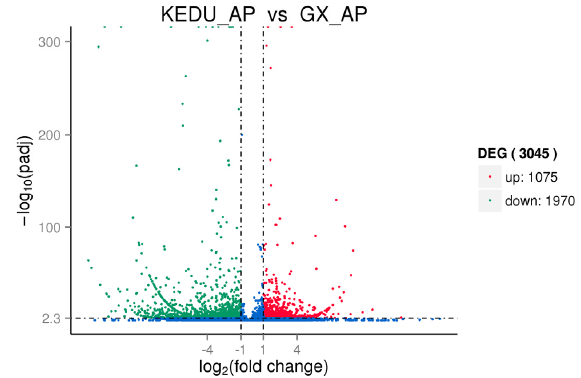
Figure 4. Differentially expressed genes (DEGs) identified between KEDU_AP and GX_AP. The red dots represent significant up-regulated genes and the green dots represent down-regulated